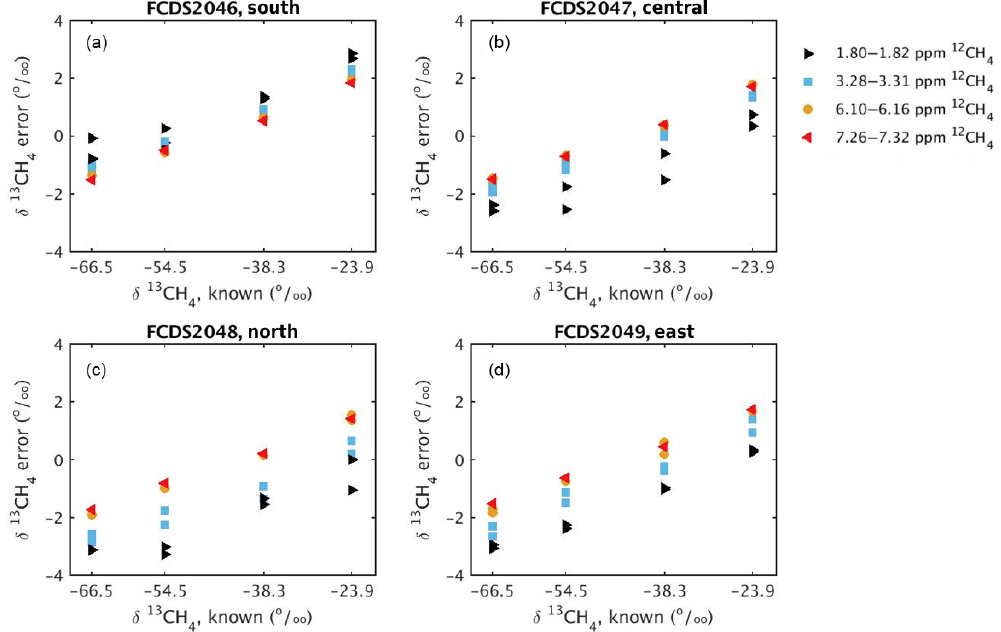
Figure 5. Measured isotopic ratio error as a function of known isotopic ratio for each of the four analyzers (a–d) , prior to calibration . The colors indicate the 12 CH 4 mole fraction, as shown in the legend. The serial numbers (FCDS2046, FCDS2047, FCDS2048, and FCDS2049) of the analyzers are indicated as well. These analyzers were deployed at the south, central, north, and east towers, respectively. Interpolating from the Allan standard deviation results (Fig. 2), the estimated precision is 0.40‰ for the 1.80–1.82ppm CH 4 tests, 0.34‰ for